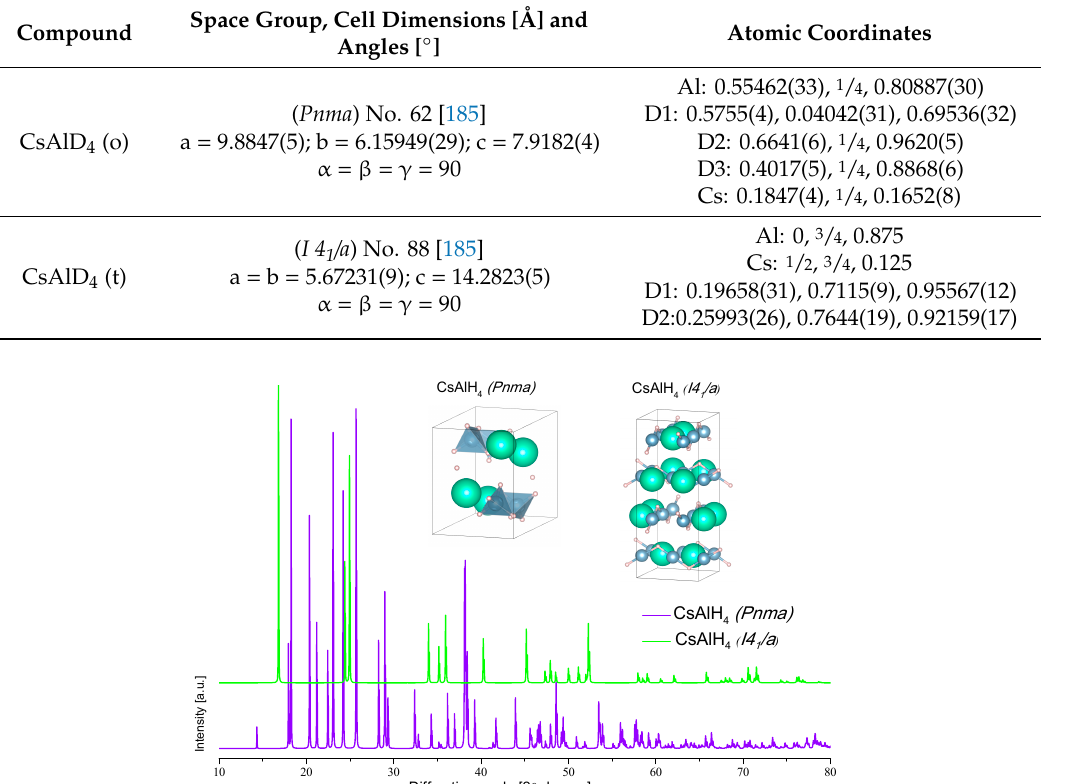
Table 6 lists the collected experimental crystallographic data of cesium alanates (Figure 12). Table 6. Crystallographic data of Cs-alanates. Table 6. Crystallographic data of Cs-alanates.